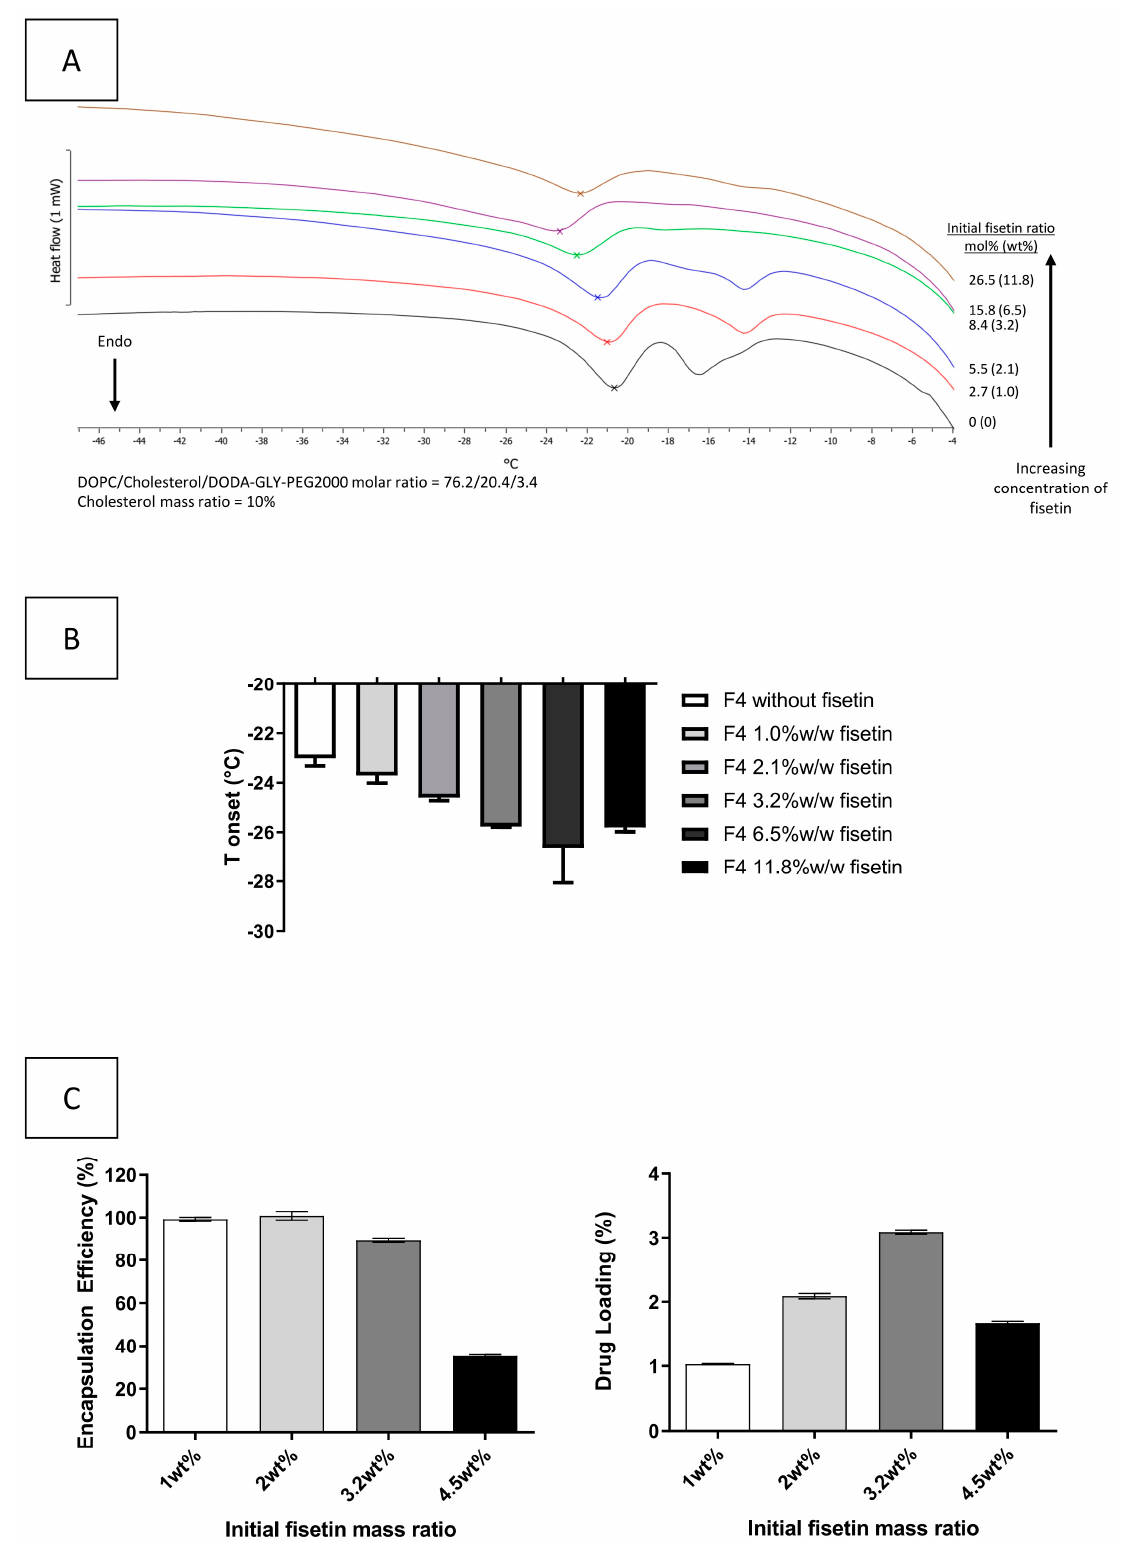
Figure 2. Influence of fisetin insertion into the lipid bilayer. ( A ) Representative DSC thermograms of the melting of DOPC contained in the lipid bilayer of liposomes with increasing amount of fisetin at cholesterol mass ratio of 10%, n = 3. ( B ) Modification of the Tonset of the DOPC melting in function of the proportion of fisetin inserted (mean ± SD, n = 2). ( C ) Encapsulation efficiency and drug loading of fisetin-loaded liposomes with increasing amount of fisetin incorporated into the formulation (mean ± SD, n =